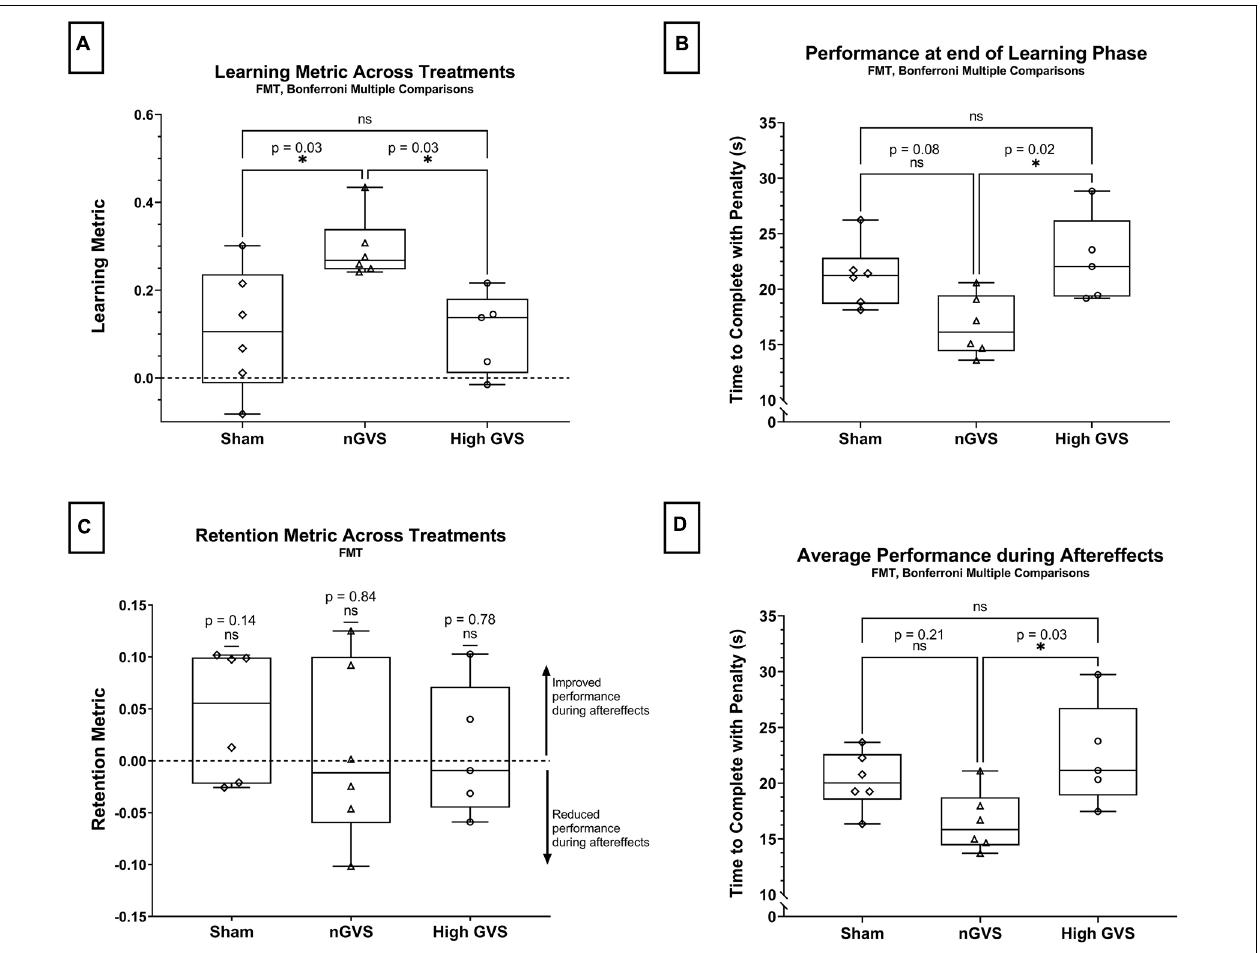
FIGURE 3 | FMT data analysis. The symbol * denotes significant comparisons at α = 0.05. (A) Comparison of learning metric across treatments. (B) Comparison of time to complete the course (with penalties) at the end of the learning phase (L end ) across treatments. (C) Comparison of retention metric across treatments shows no significant change in performance between end of learning phase and average performance during aftereffects for any treatment. (D) Average time to complete the course (with penalties) during aftereffects (AE avg ) across treatment